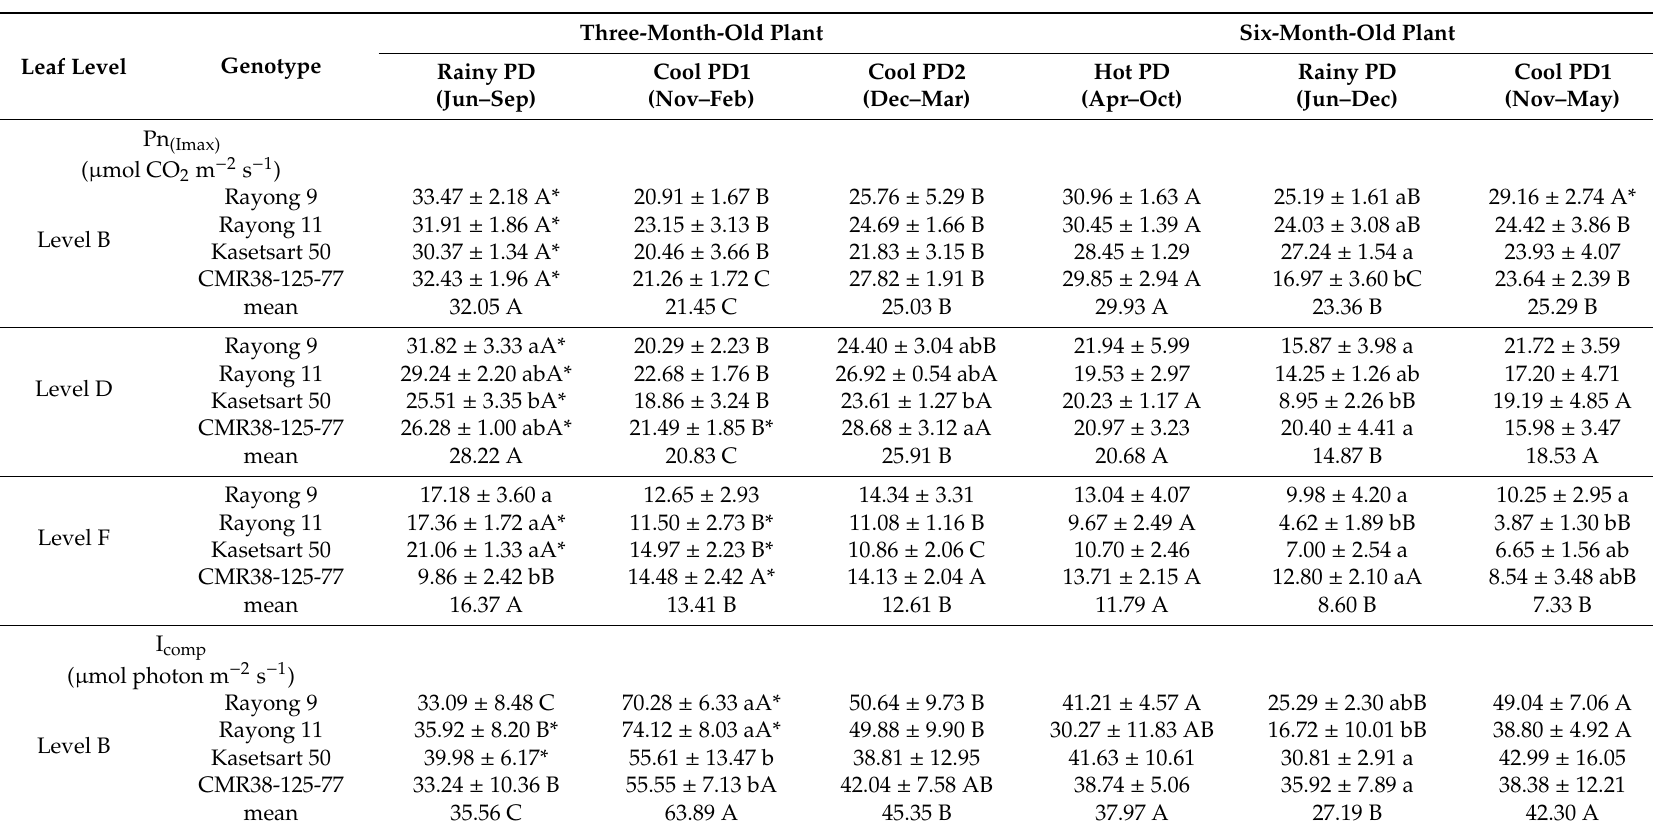
Table 3. Net photosynthetic rate at light saturation (Pn (Imax) ), light compensation point (I comp ), light saturation (I max ), and apparent quantum yield (AQE) of cassava predicted from the light response curves constructed from leaves at three canopy levels (upper leaves, Level B; middle leaves, Level D; and lower leaves, Level F) of the 3- and 6-month-old cassava plants. Means that were significantly di ff erent ( p < 0.05) among genotypes are denoted with di ff erent lower case letters, and those among PDs by di ff erent capital letters. The significant di ff erences ( p < 0.05) between the 3- and 6-month-old plants in the same PD are denoted with